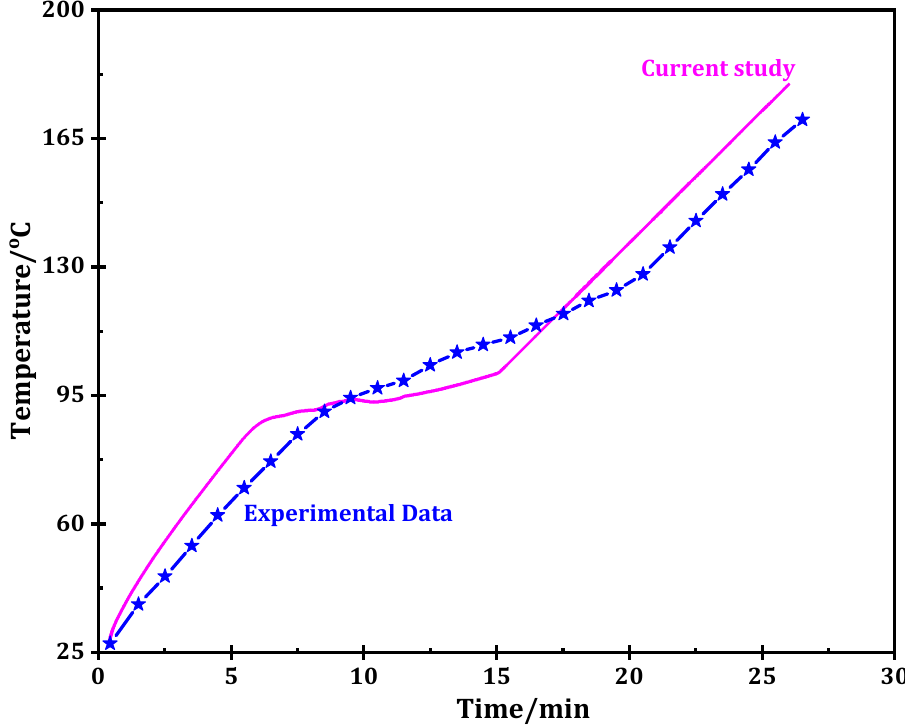
Figure 3. Comparison between the current study and the experimental data [20].